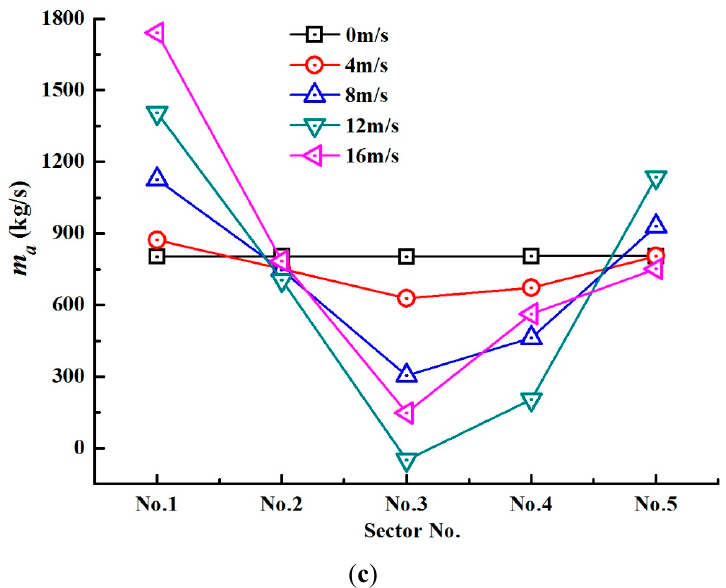
Figure 7. Thermo-flow performances of various sectors at different wind speeds. ( a ) Overall outlet air temperatures at 4 m/s, ( b ) overall outlet temperatures at 12 m/s, ( c ) air mass flow rate, ( d ) heat